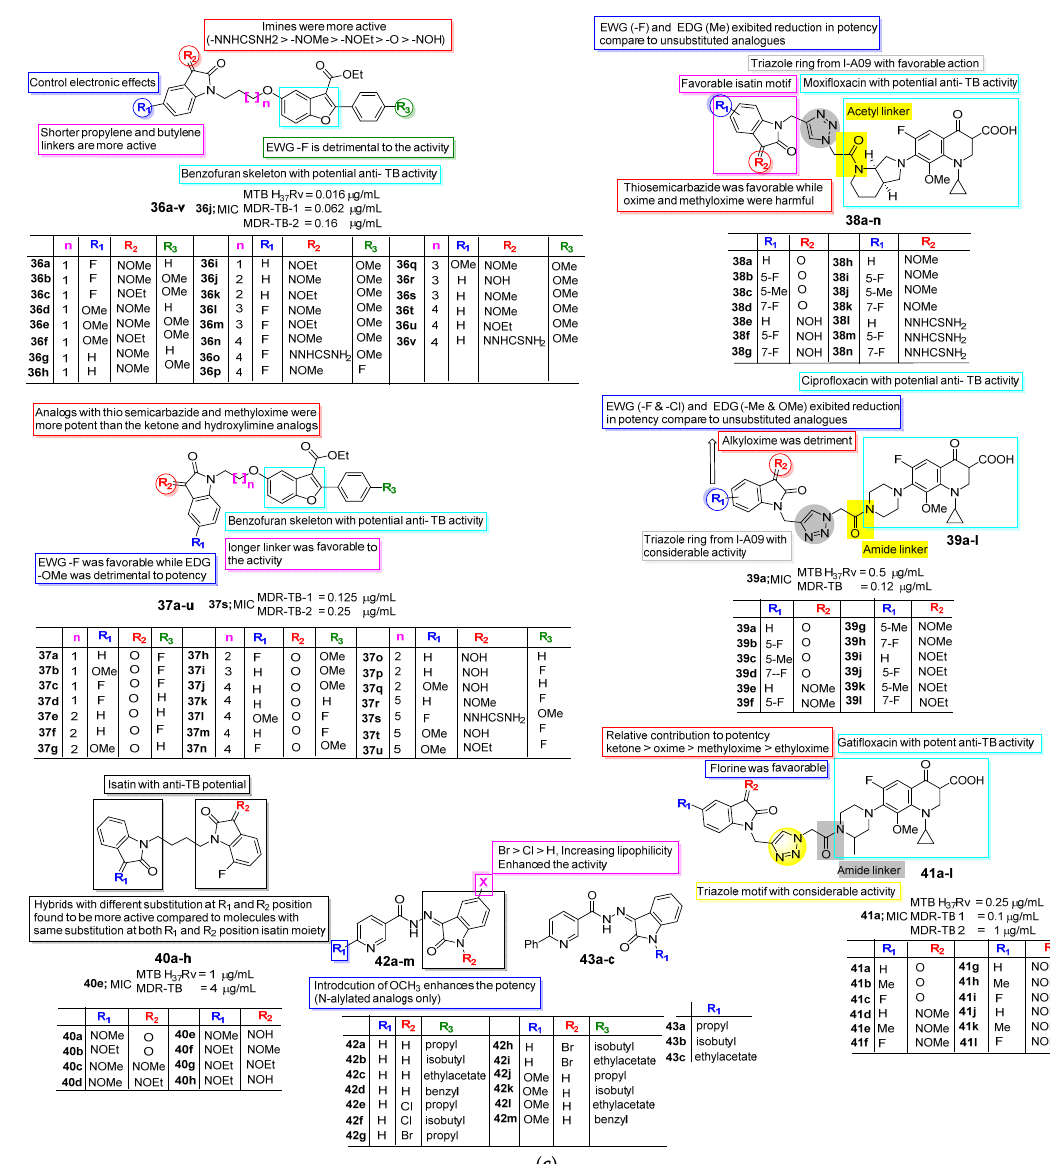
Figure 4. ( a ) Isatin analogues with potential anti-TB activity and identified SAR characteristics. ( b ) Isatin analogues with potential anti-TB activity and their SAR characteristics. ( c ) Isatin analogues with potential anti-TB activity and SAR characteristics.